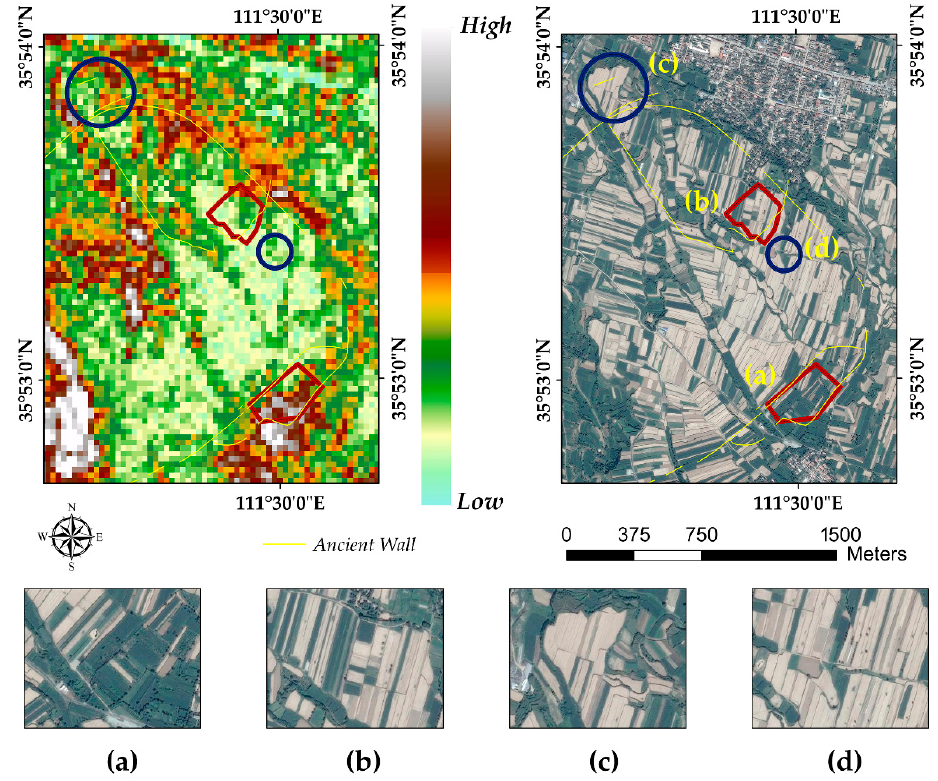
Figure 10. The distribution of positive crop anomalies and main archeological features. ( left ) Landsat NDVI of 13 September 2001. ( right ) Google Earth image of 30 August 2013: ( a ) southern sacrifice area and the ancient astronomical observatory, 2003–2005; ( b ) palace area, 2002–2007; ( c ) northern sacrifice area outside the walled site with northern wall, 2000–2004; ( d ) regions of dense cellar holes, 2001. The features have been refilled after an excavation project.